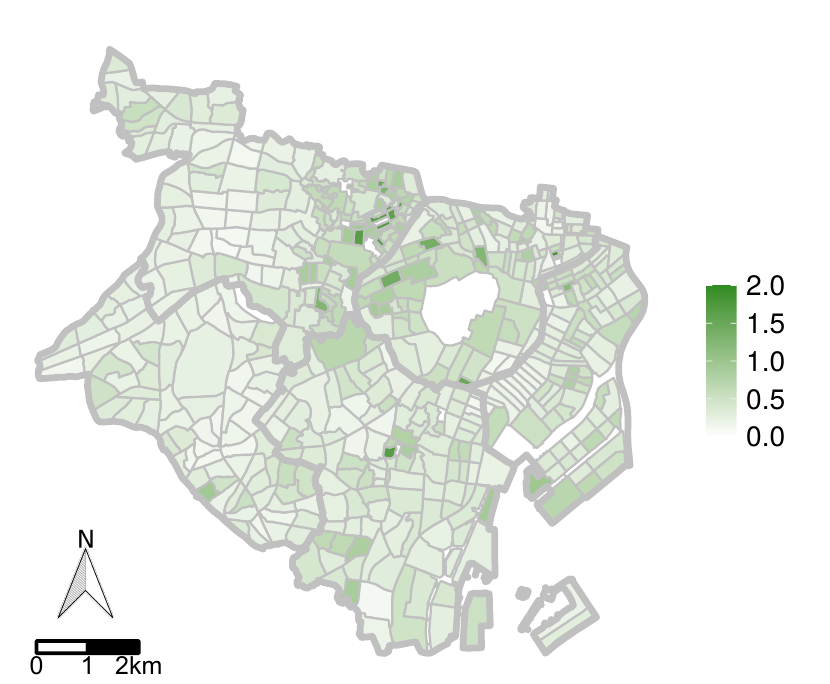
Figure 7. Standard deviations of estimated subregion-based